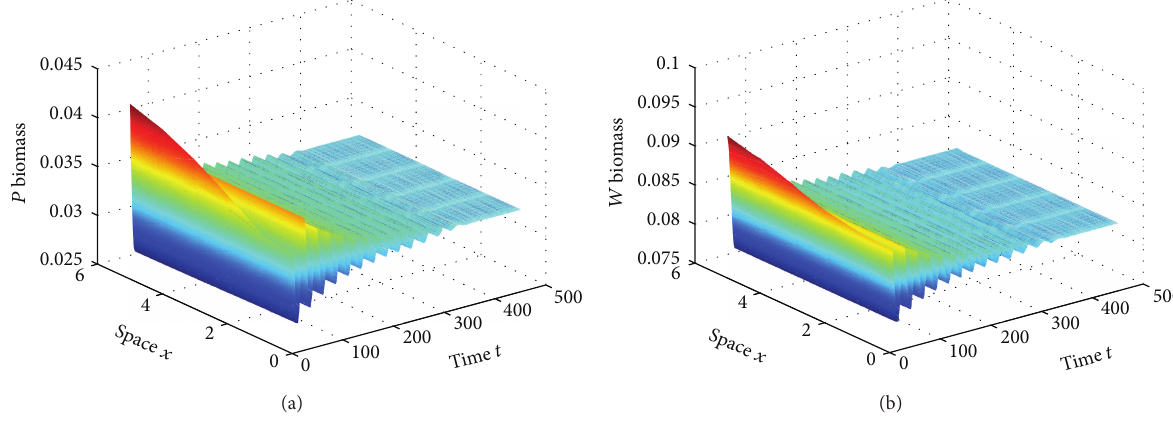
Figure 1: Stable positive constant steady state 𝐸 ∗ = ( 0 . 03345633121 , 0 . 08364082803 ) of system (2) for 𝑠 = 0 . 25, 𝑏 = 0 . 1, 𝑎 = 10, 𝑘 = 0 . 2, = 1, and 𝑑 = 1 and initial conditions (𝑃 𝑑 1 2